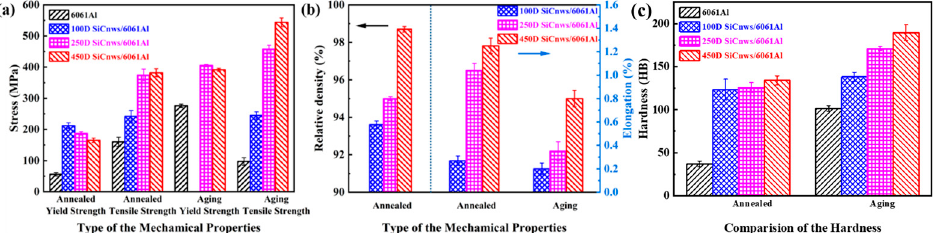
Figure 11. The tensile performance and relative density of 6061Al, 20vol.% 100D, 250D and 450D SiCnw/6061Al composites. ( a ) Comparison of the yield and tensile strength, ( b ) Comparison of the relative density and elongation, ( c ) Hardness.